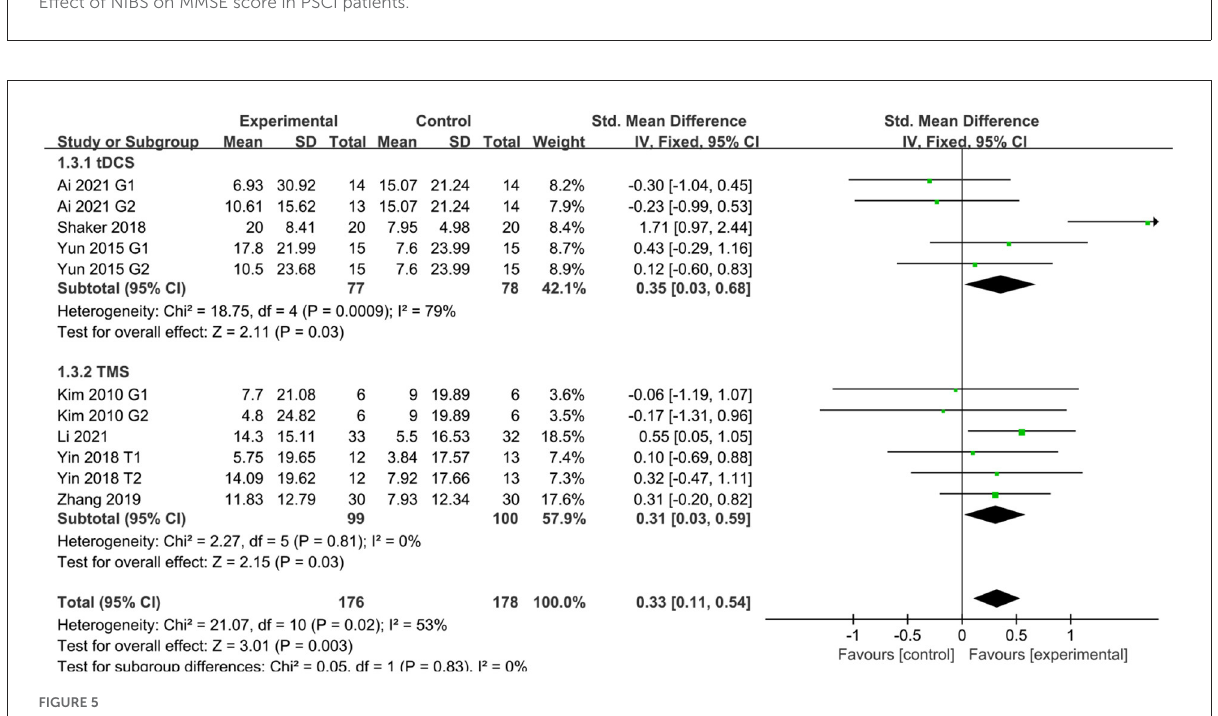
FIGURE4 Effect of NIBS on MMSE score in PSCI patients.